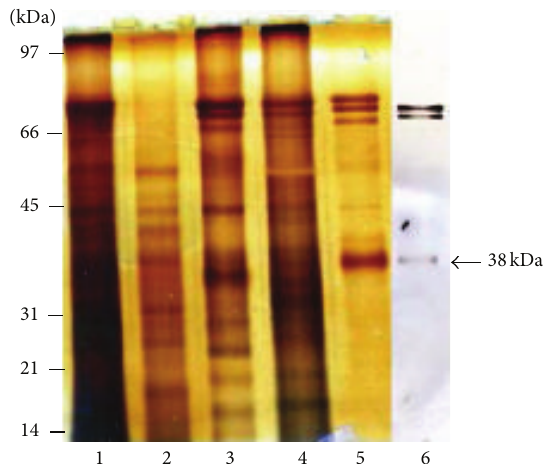
Figure 3: Silver stained SDS-polyacrylamide gel electrophoresis demonstrating the purification of 38 kDa RCA binding